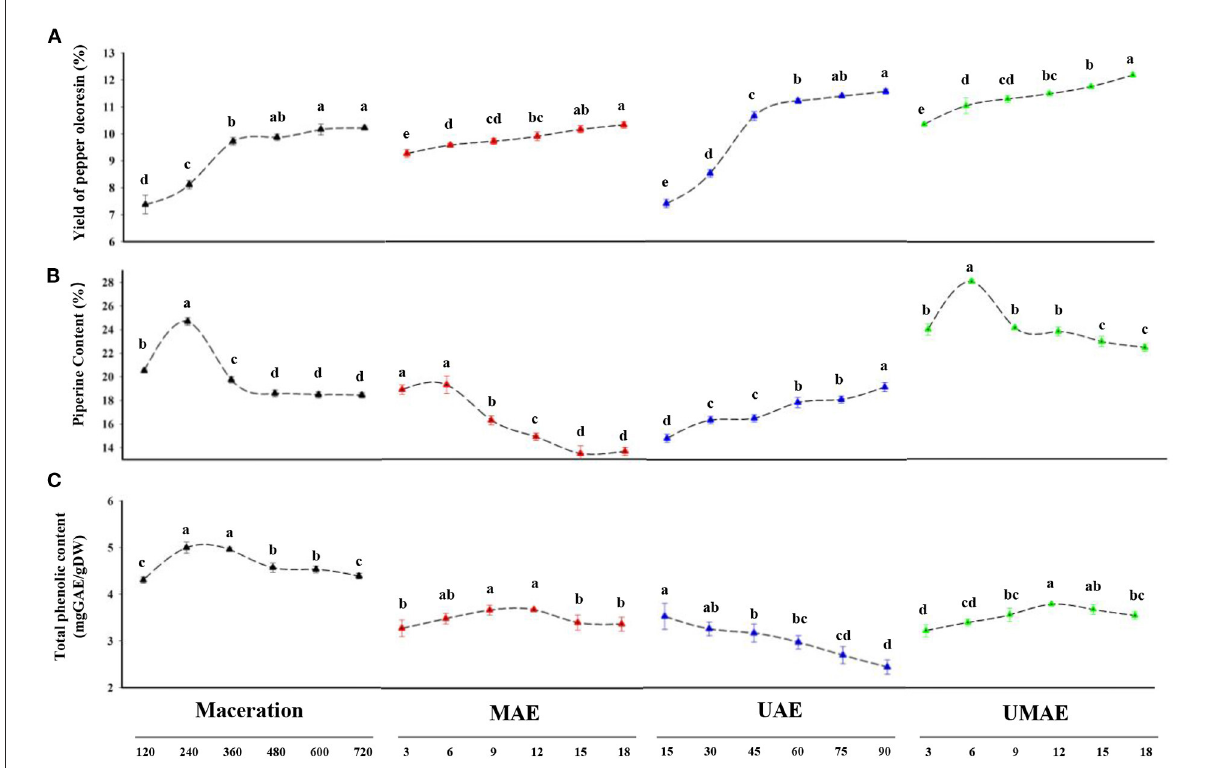
FIGURE1 Comparison of yield, piperine content, and total phenolic content of extract from maceration, UAE, MAE, and UMAE at different extraction times (3–720min). (A) Yield of pepper oleoresin. (B) Piperine content of pepper oleoresin. (C) Total phenolic content expressed mg GAE/g DW. Different letters in the same treatment indicate a statistical difference ( p <